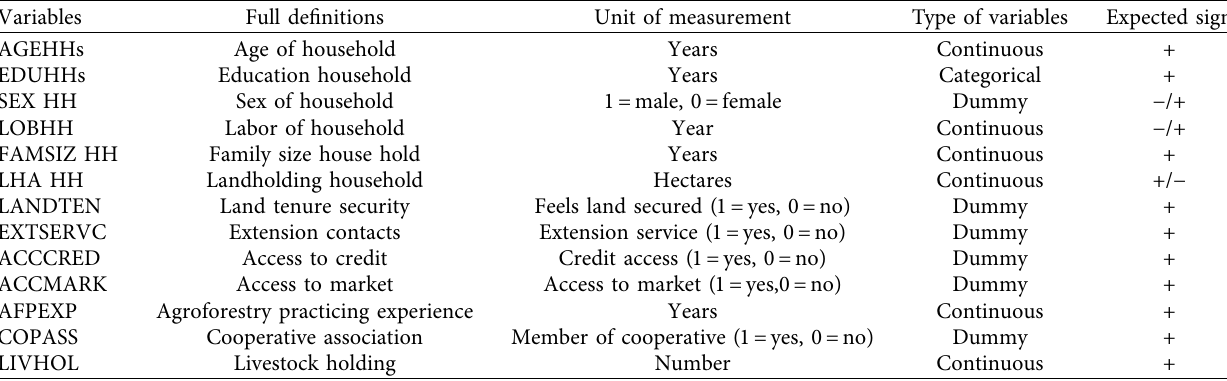
Table 2: Description of explanatory variables and expected signs of the efect of agroforestry practices on household farm income. Variables